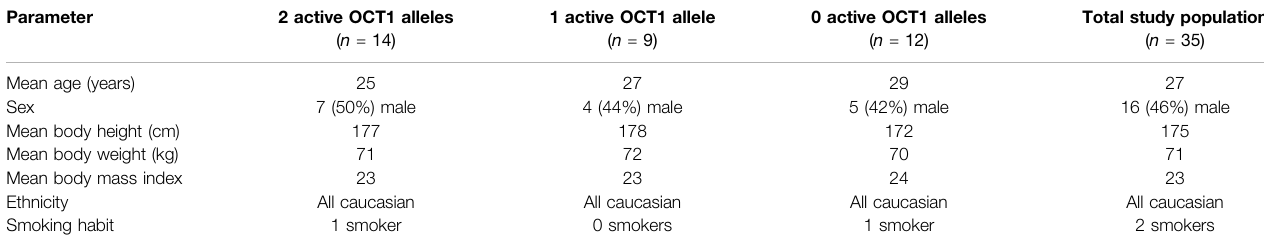
TABLE 1 | Demographic data of the healthy volunteer study population strati fi ed by OCT1 genotype.